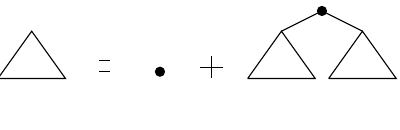
Fig. 1: Complete binary